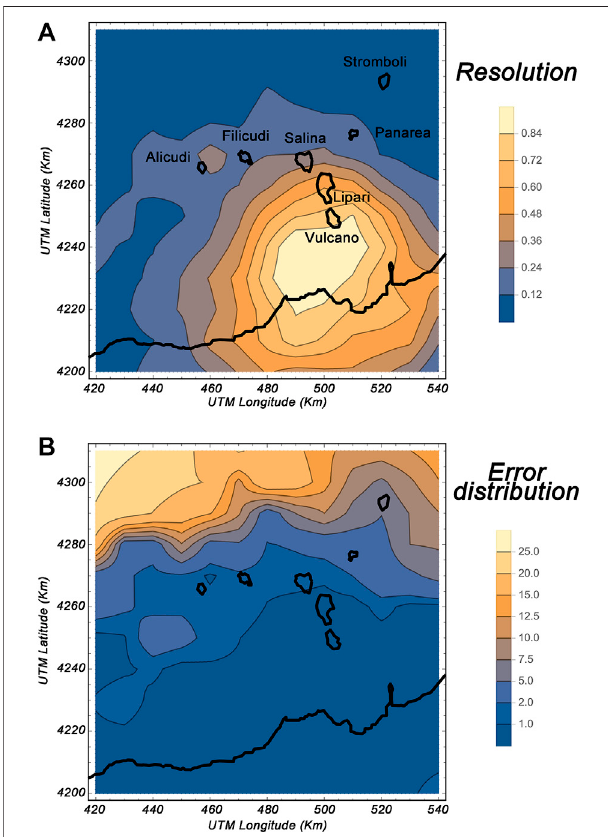
FIGURE 5 | Resolution tests to provide a quality check of the validity of the obtained images. Resolution tests showing the spatial distribution of (A) calculated standard deviation σ and (B) estimated errors. The results for the AeolianIslandsstudyregioncon fi rmthatthedataarereliableand canbe used for